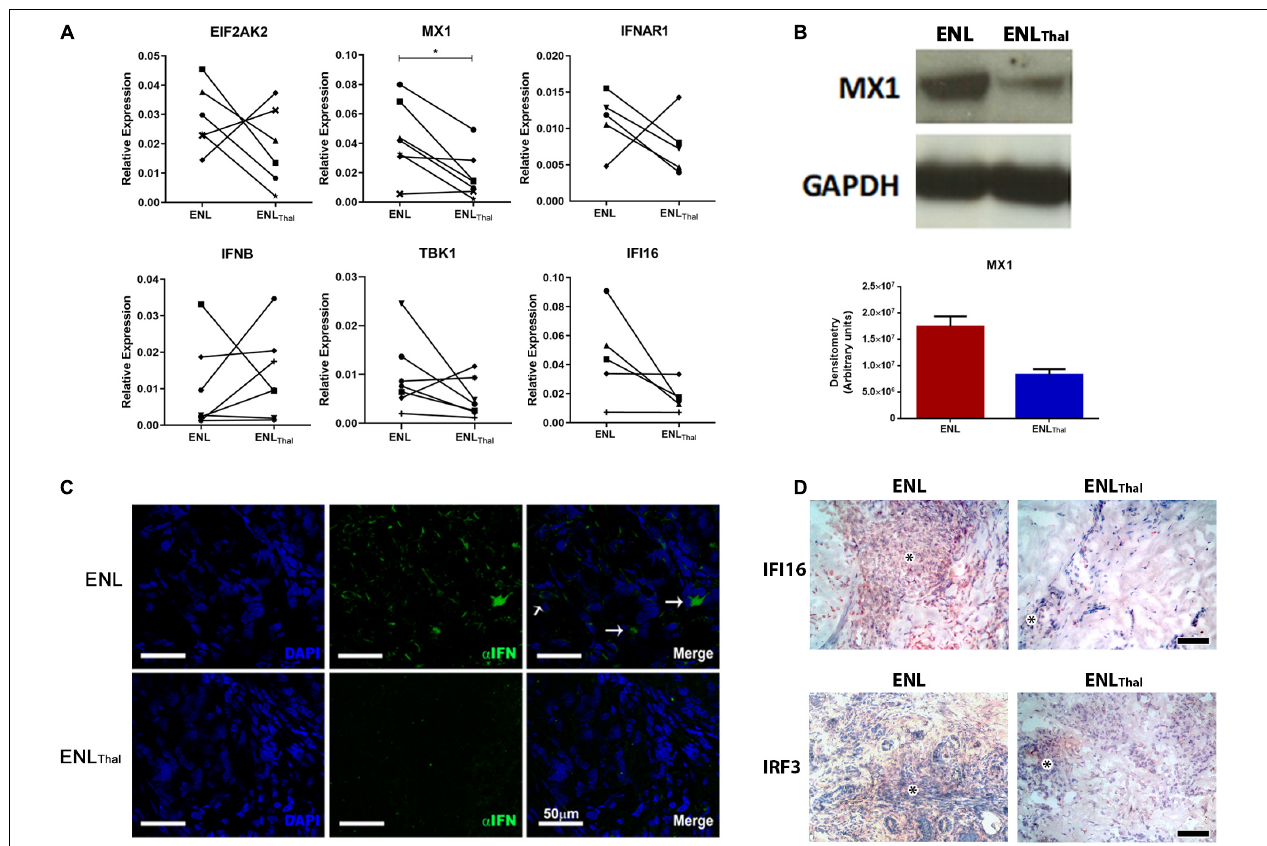
FIGURE 3 | Thalidomide treatment decreases IFN-I pathway activity in skin lesions of ENL patients. (A) Follow-up of ENL patients before (ENL) and after 7 days of thalidomide treatment (ENL Thal ). Skin lesions were processed in TRIzol R (cid:13) for RNA extraction. Gene expression was determined by RT-qPCR for the following genes: EIF2AK2 ( n = 6), MX1 ( n = 7), IFNAR1 ( n = 5), IFNB ( n = 7), TBK1 ( n = 7), and IFI16 ( n = 7). RPL13 was used as an endogenous control. (B) Top – Longitudinal follow-up of MX1 protein levels by Western blot in skin lesions before (ENL = 3) and on Day 7 of thalidomide treatment (ENL Thal = 3). GAPDH was used as an endogenous constitutive gene. Bottom – Densitometry analysis displayed in arbitrary units. (C) Immunofluorescence for IFN- α ( green ) of skin lesions of ENL patients ( n = 3) and ENL Thal ( n = 3). Cell nuclei are in blue by DAPI staining. White arrows ( → ) indicate IFN- α labeling in the merge images. Scale bar = 50 µ m. (D) Representative immunohistochemical analysis of IFI16 and IRF3 proteins in skin lesions of ENL and ENL Thal patients. Inflammatory infiltrate is indicated by the asterisk symbol. The photomicrographs are representative of four patients from each group. Scale bar = 100 µ m. ∗ p < 0.05.